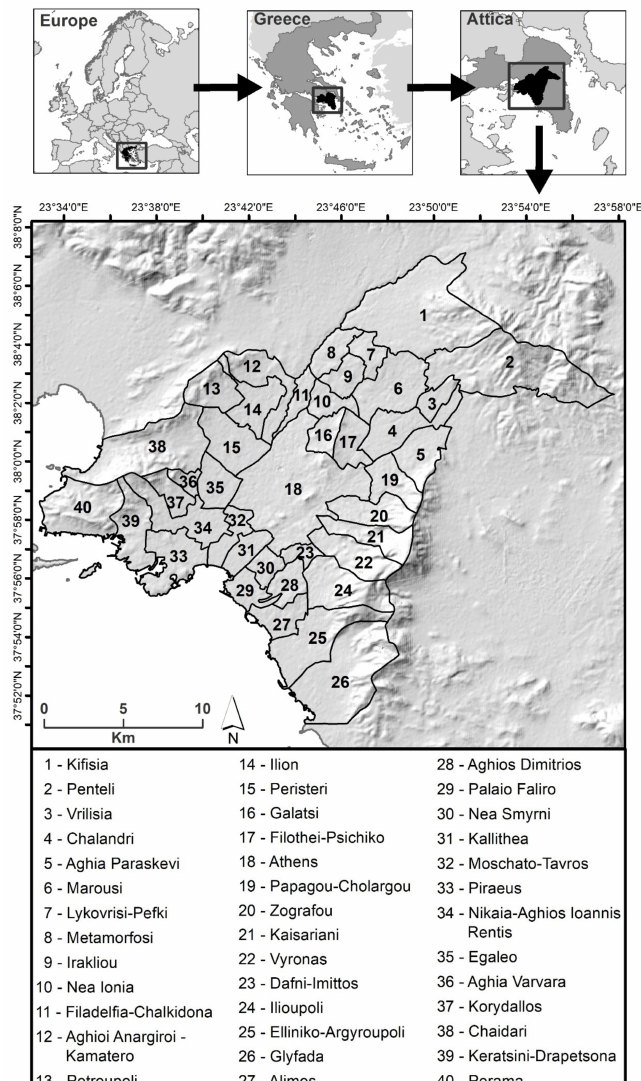
Figure 1. The study area of Athens Metropolitan Area, in Attica,